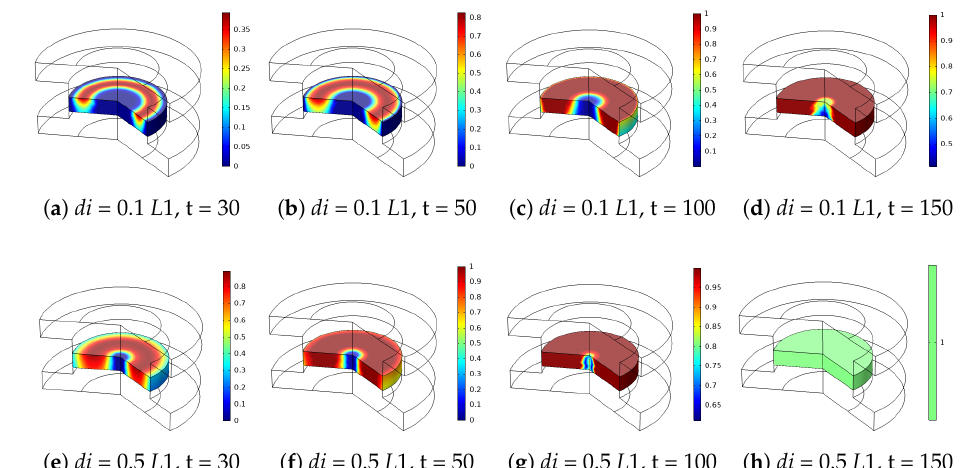
Figure 11. Distribution of time dependent liquid fraction within the cavity with varying port sizes